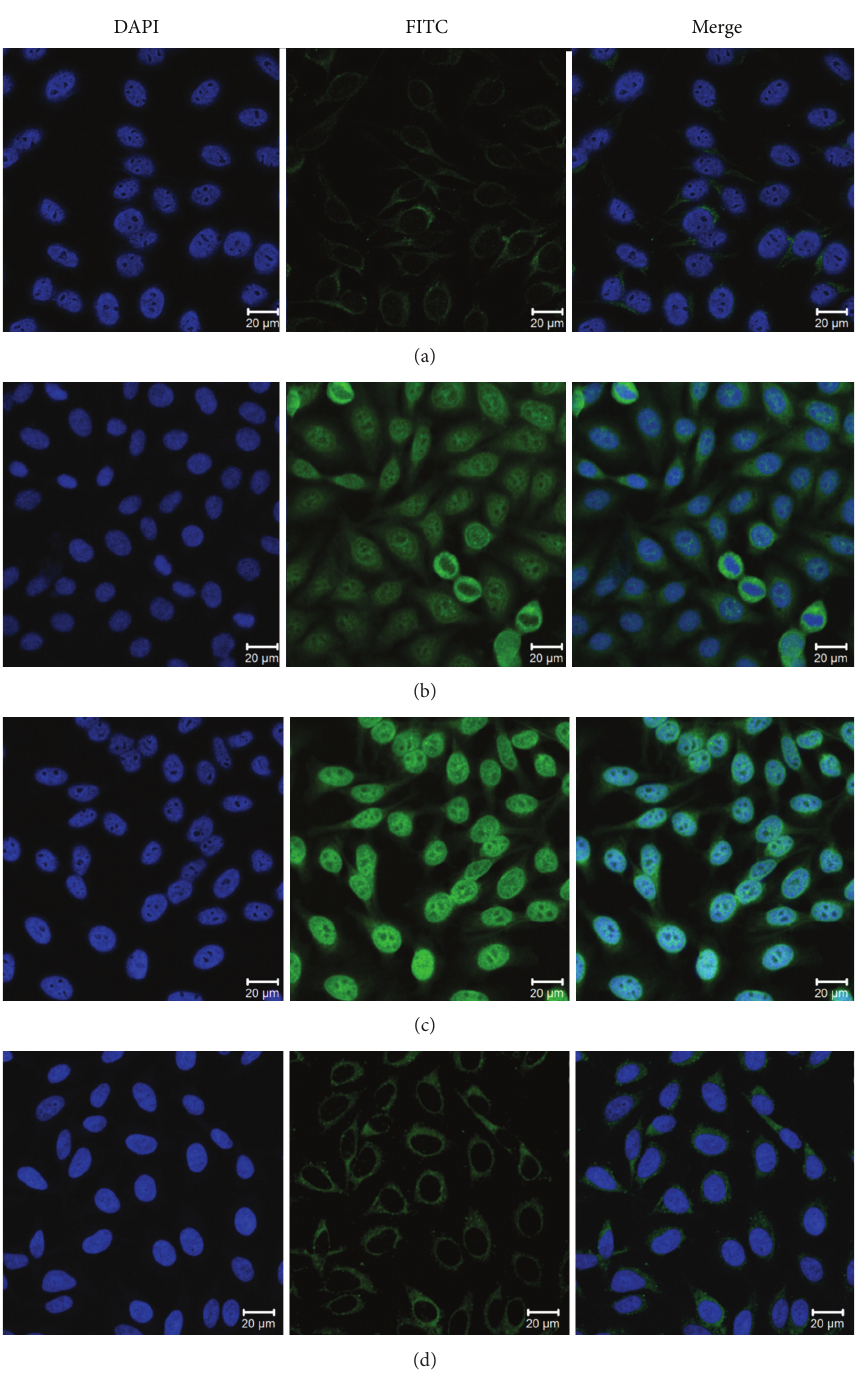
Figure 4: Representative immunofluorescence staining pattern of anti-MDM2 autoantibody positive HCC serum (performed on Hep2 antinuclear antigen tissue slides). (a) NHS were used as negative control; (b) polyclonal anti-MDM2 antibody which showed a nuclear immunofluorescence staining pattern was used as positive control; (c) a representative anti-MDM2 autoantibody positive HCC serum demonstrated an intense nuclear staining pattern; (d) the same HCC serum used in panel (c) was preabsorbed with recombinant MDM2. The nuclear fluorescent staining was significantly